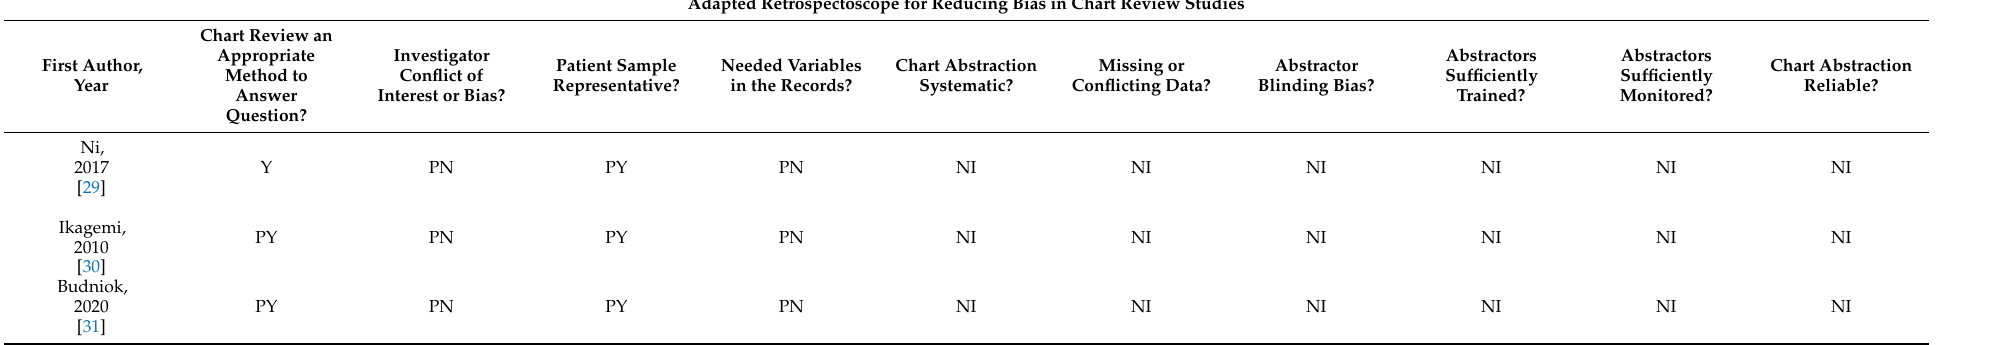
Table 2. Risk of bias assessment of individual retrospective